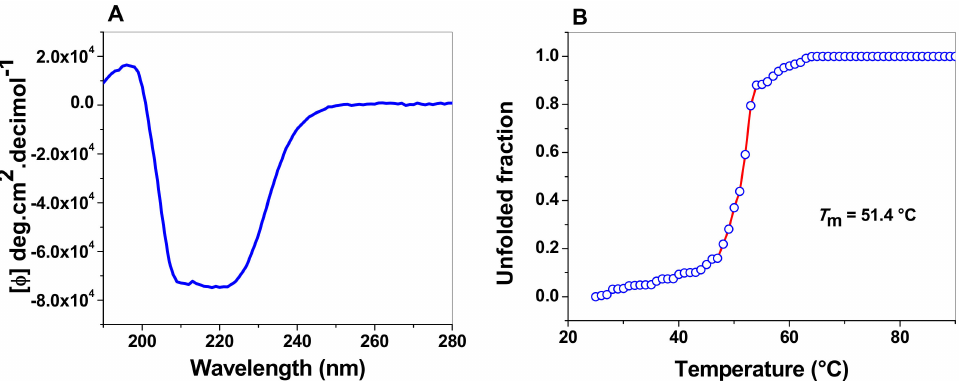
Figure 7. Spectroscopic properties of FoxTPI. ( A ) Far-UV CD spectra of the FoxTPI protein. The protein concentration was 0.4 mg / mL in TE bu ff er at 25 ◦ C, and the experiments were performed in triplicate. The spectra of blanks were subtracted from those that contained the protein; ( B ) thermal denaturation of FoxTPI. The data are the mean of at least three independent